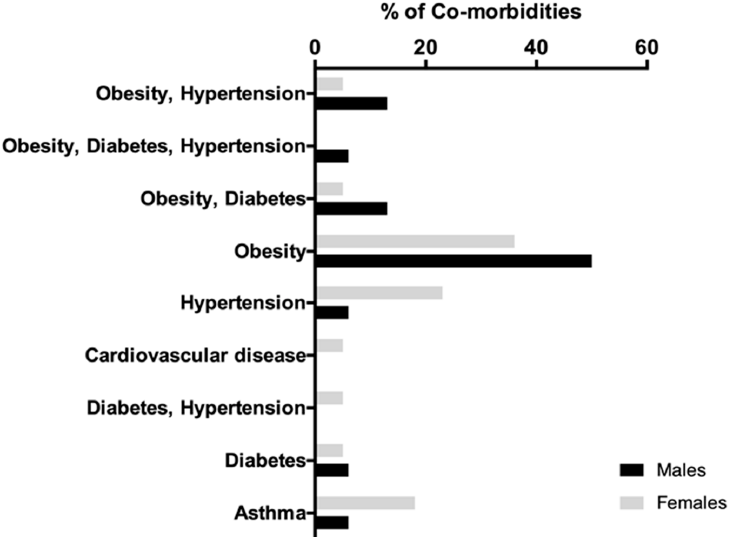
Figure 1. Representation of frequency for the most common co-morbidities present in the O.S.M. ( n = 38) in an oncology center. This graph shows in percentage (%) the frequency of each different co-morbidities; men are represented by a solid black bar and women by a solid gray bar. Table 1. Epidemiological characteristics of 17 O.M.S./qRT-PCR positive for SARS-CoV-2 identified with the algorithms ( n =